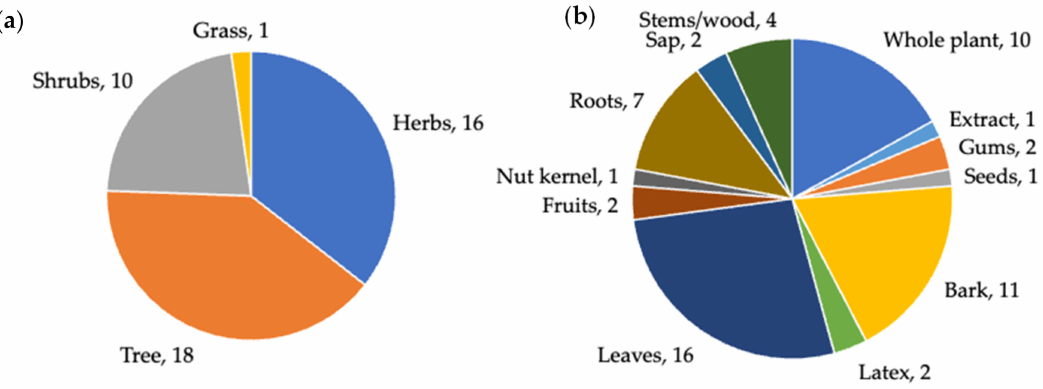
Figure 3. Anti-inflammatory medicinal plants of tropical Australia: ( a ) different life forms; ( b ) differ- ent parts used for medicinal